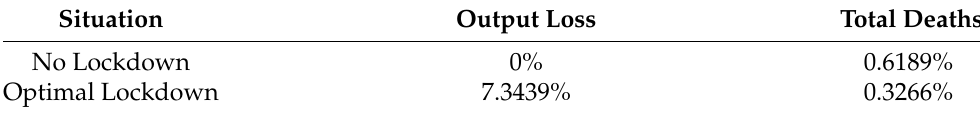
Table 2. Comparison of the optimal lockdown policy to no lockdown, using benchmark